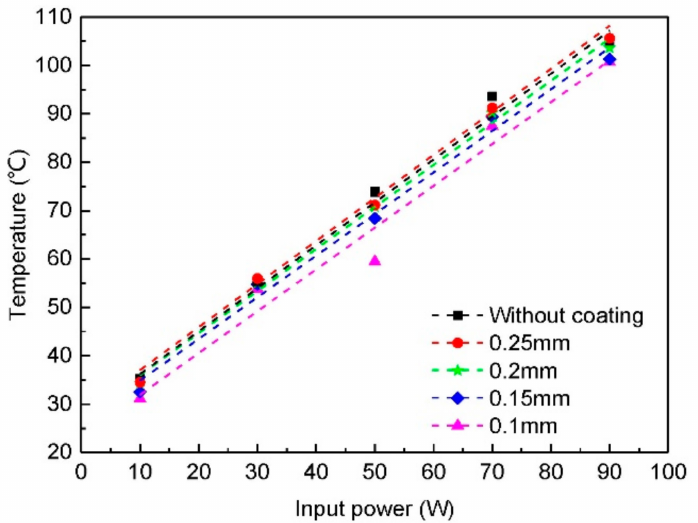
Figure 7. Influence of thermal radiation coating thickness on the temperature of heat sinks.